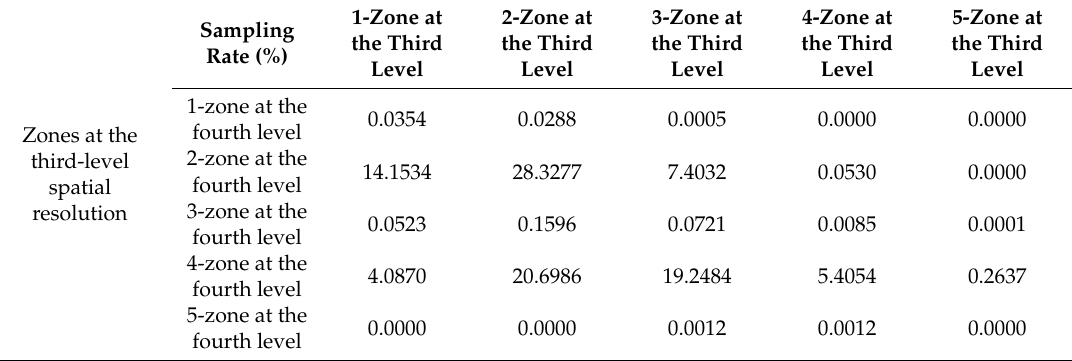
Table 3. Sampling rate of each zone at the third-level spatial resolution (18-m).